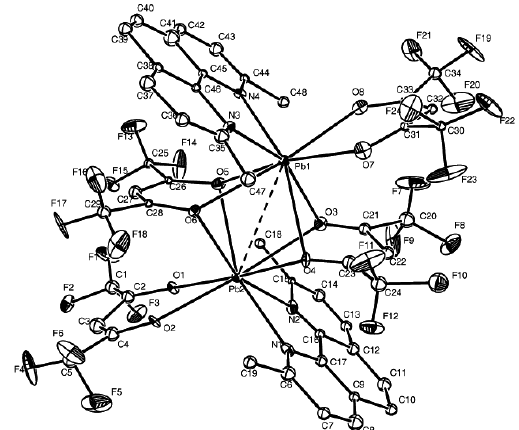
Figure 1. ORTEP diagram of [Pb